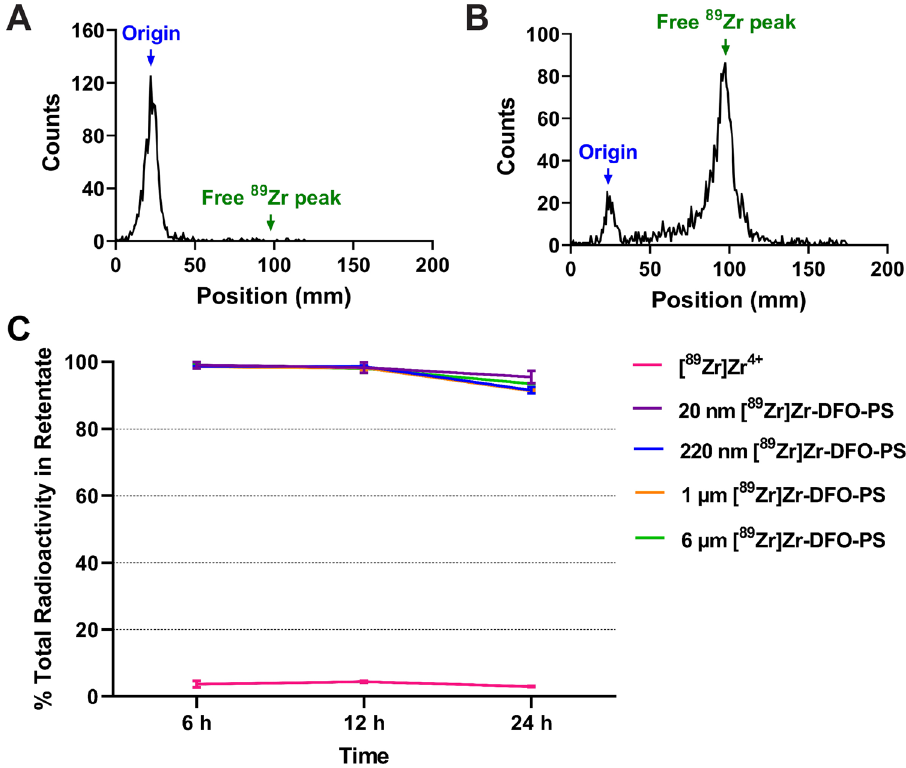
Figure 6. The in vivo stability of [ 89 Zr]Zr-DFO-PS particles. Representative iTLC chromatograms of the homogenized gastrointestinal contents of mice collected 12 h after the administration per os of (A) [ 89 Zr] Zr-DFO-PS and (B) [ 89 Zr]Zr 4+ . ( C ) The percentage of the total radioactivity remaining in the retentate after the centrifugal filtration (Amicon Ultra-15; 100 kDa molecular weight cut-off) of the contents of the gastrointestinal tracts of mice collected 6, 12, and 24 h after the administration per os of [ 89 Zr]Zr-DFO-PS (20 nm, 220 nm, 1 µm or 6 µm) or [ 89 Zr]Zr 4+